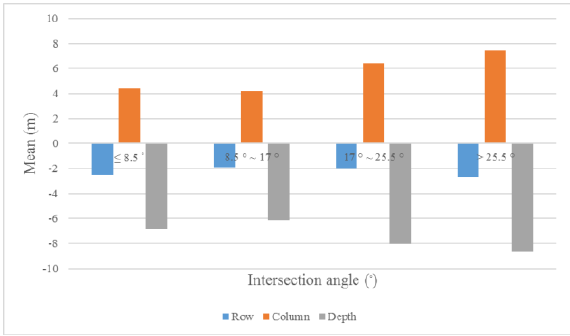
Figure 15. Mean difference in case of different intersection angles